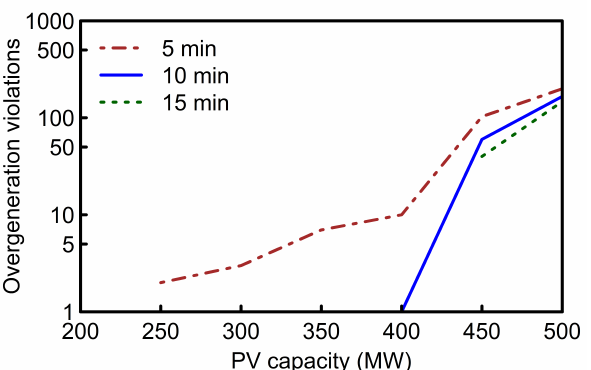
Figure 7. Example day over-generation violation count. In this approach a violation count is recorded when the dispatch imbalance exceeds 20 MW over defined consecutive minutes (5, 10 and 15).